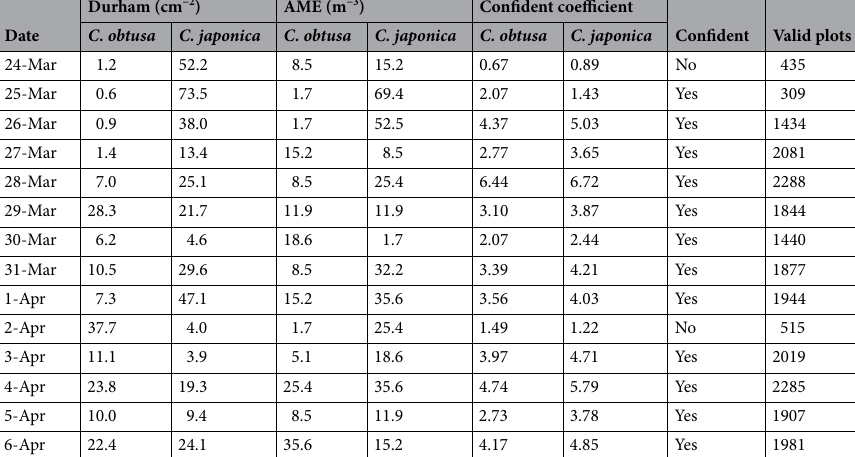
Table 2. Summary of number of pollen grains and confidence